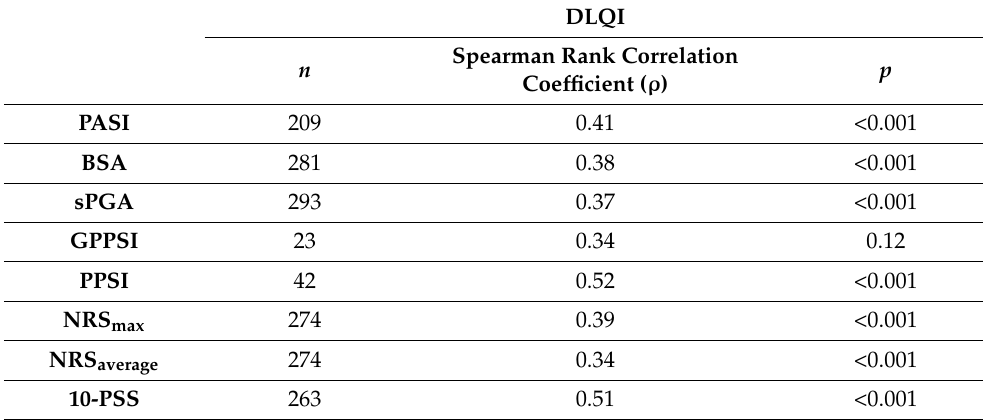
Table 2. Correlations between Dermatology Life Quality Index (DLQI) and indices of psoriasis severity and pruritus intensity according to Spearman rank correlation test (10-PSS—10-item Pruritus Severity Scale, BSA—Body Surface Area, GPPSI—Generalized Pustular Psoriasis Severity Index,